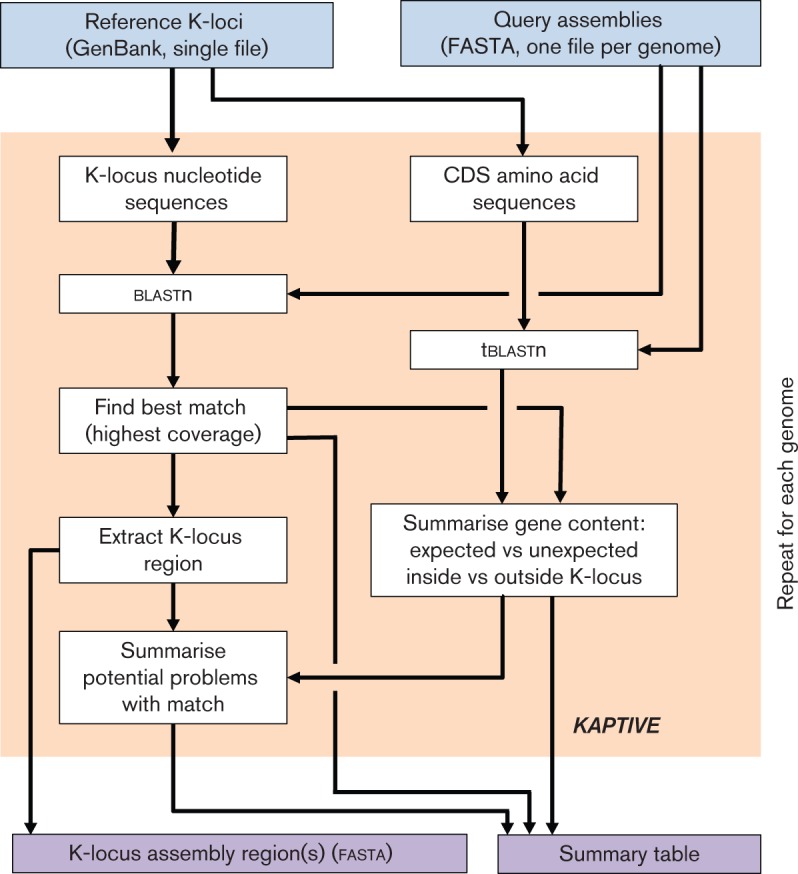
Summary of the Kaptive analysis procedure. Kaptive takes as input a set of annotated reference K-loci in GenBank format and one or more genome assemblies, each as a single fasta file of contigs. Kaptive performs a series of blast searches to identify the best-match K-locus in the query genome and assess the presence of genes annotated in the best-match locus (expected genes) and those annotated in other loci (unexpected genes) both within and outside the putative K-locus region of the query assembly. The output is a fasta file containing the nucleotide sequence(s) of the K-locus region(s) for each query assembly and a table summarizing the best-match locus, gene content and potential problems with the match (e.g. the assembly K-locus region is fragmented, expected genes are missing from the K-locus region or at low identity, or unexpected genes are present) for each query assembly. For the user’s convenience, Kaptive will also use blastn to find and report the best match wzi and wzc allele sequences, as defined in the Kp BIGSdb (not shown in schematic).